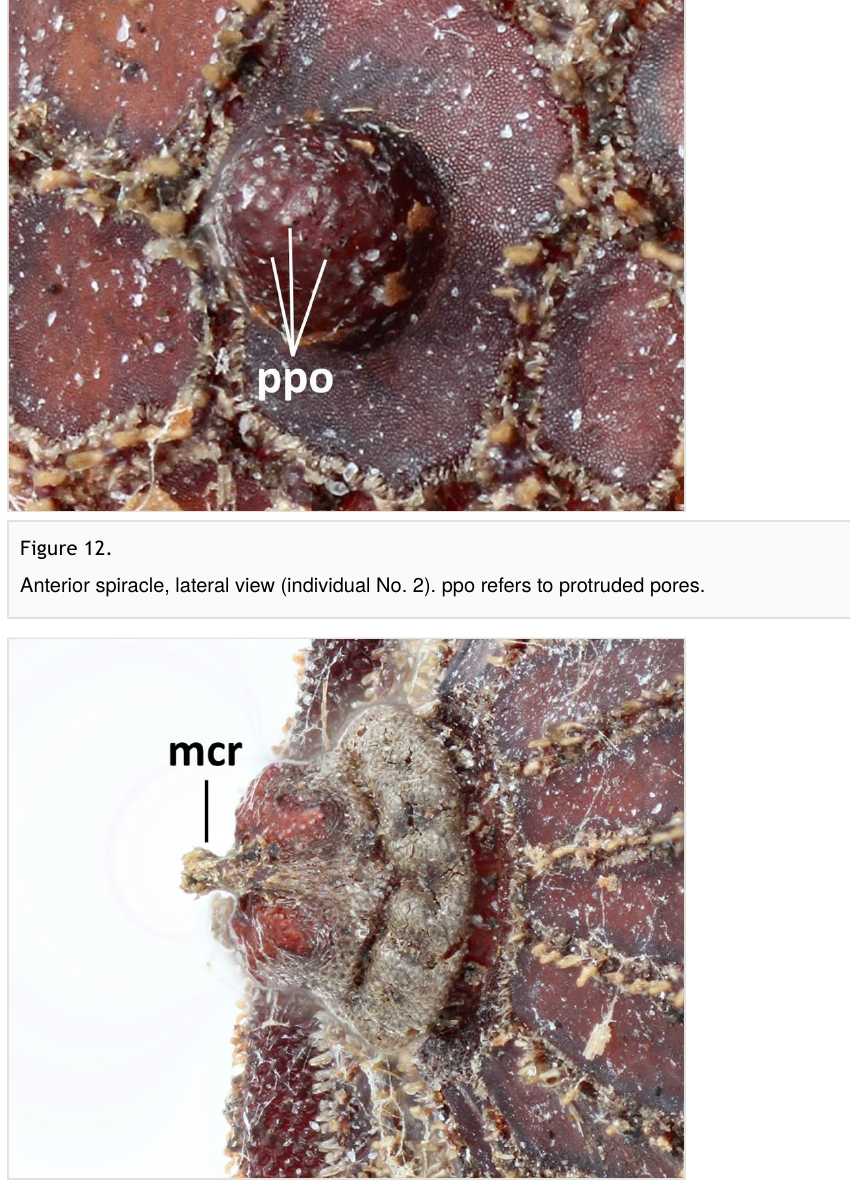
Figure 13. Posterior respiratory process, dorsal view (individual No. 2); mcr refers to median